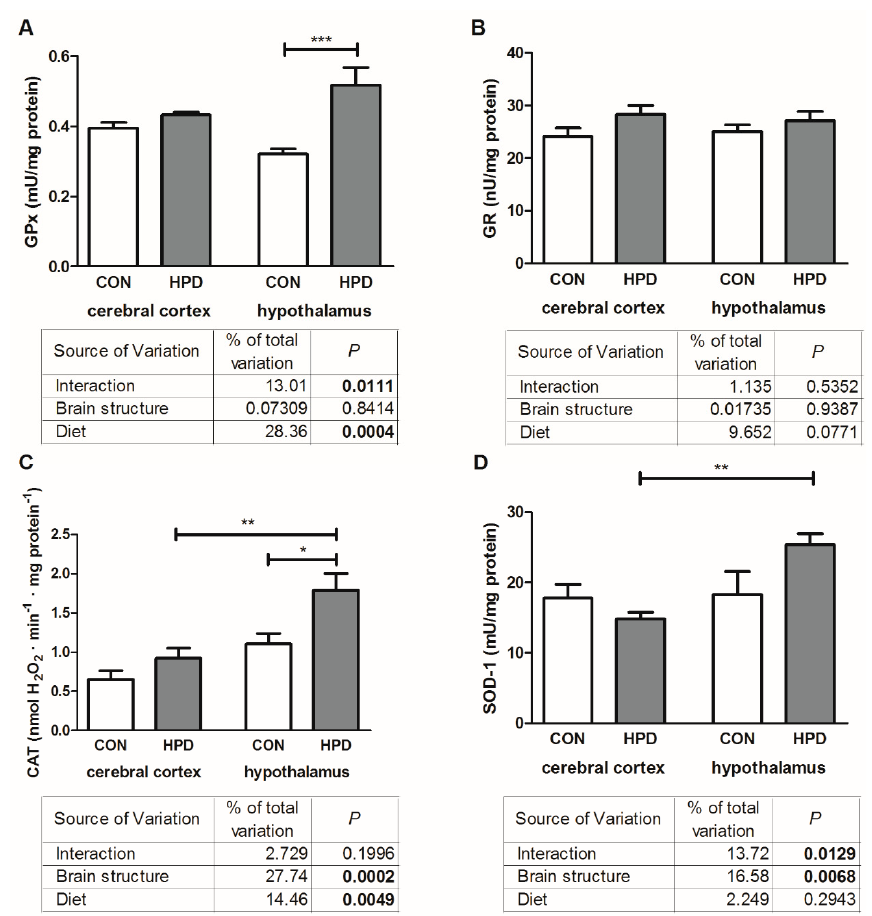
Figure 3. Effect of 8-week HPD on enzymatic antioxidants activity (glutathione peroxidase ( A ), glutathione reductase ( B ), catalase ( C ), superoxide dismutase ( D )) in rat cerebral cortex and hypothalamus. Values are means ± SEMs, n = 9. Differences statistically significant at: * p < 0.05, ** p < 0.005, *** p < 0.0005. CAT, catalase; CON, standard diet; GPx, glutathione peroxidase; GR, glutathione reductase; HPD, high protein diet; SOD-1, superoxide dismutase.